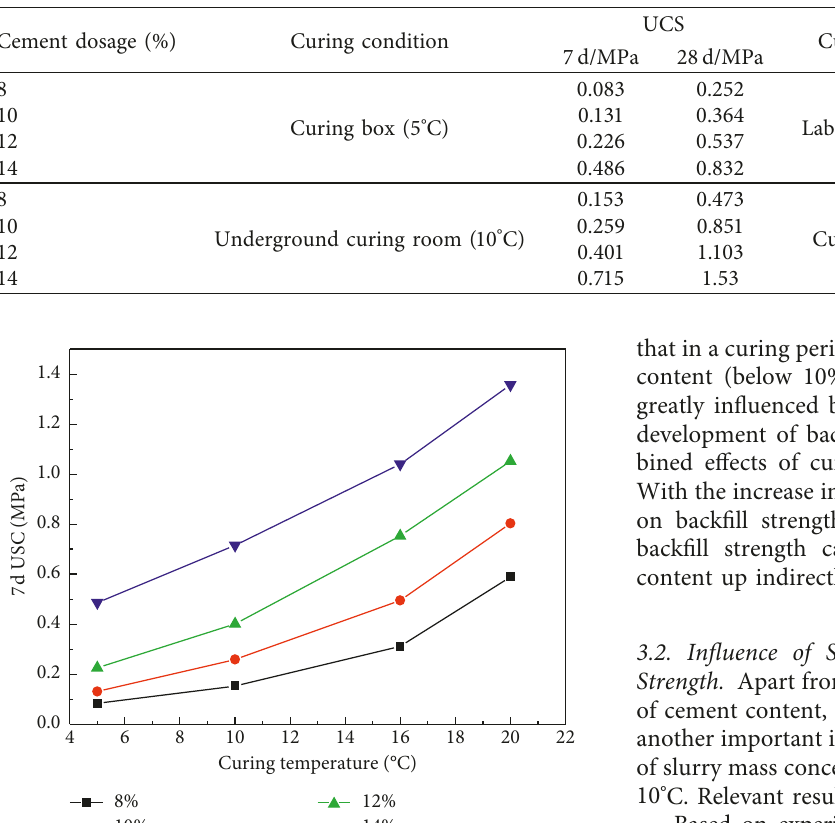
Table 1: Impact of curing temperature on backfill strength (75% wt.).